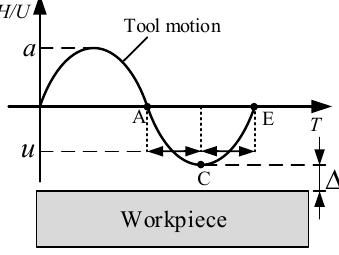
Figure 7. Schematic diagram showing tool motion and pulse duration.